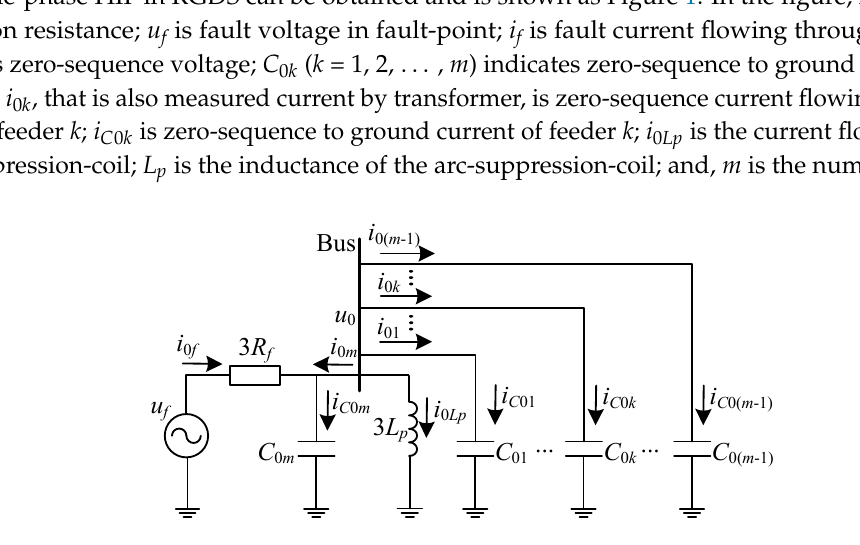
Figure 1. Equivalent zero-sequence network for single-phase high impedance faults (HIF) in resonant grounding distribution system (RGDS).